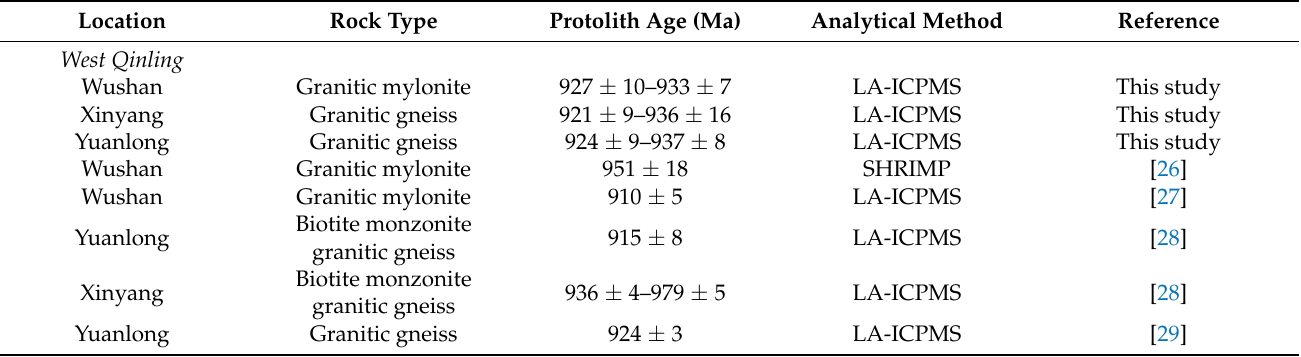
Figure 1. ( a ) Tectonic map of China (modified after [14]); ( b ) Simplified geological map of the western margin of the NQT (modified after [14,25]). Table 1. A summary of the localities, lithology, and protolith ages of the early Neoproterozoic granitic rocks in the